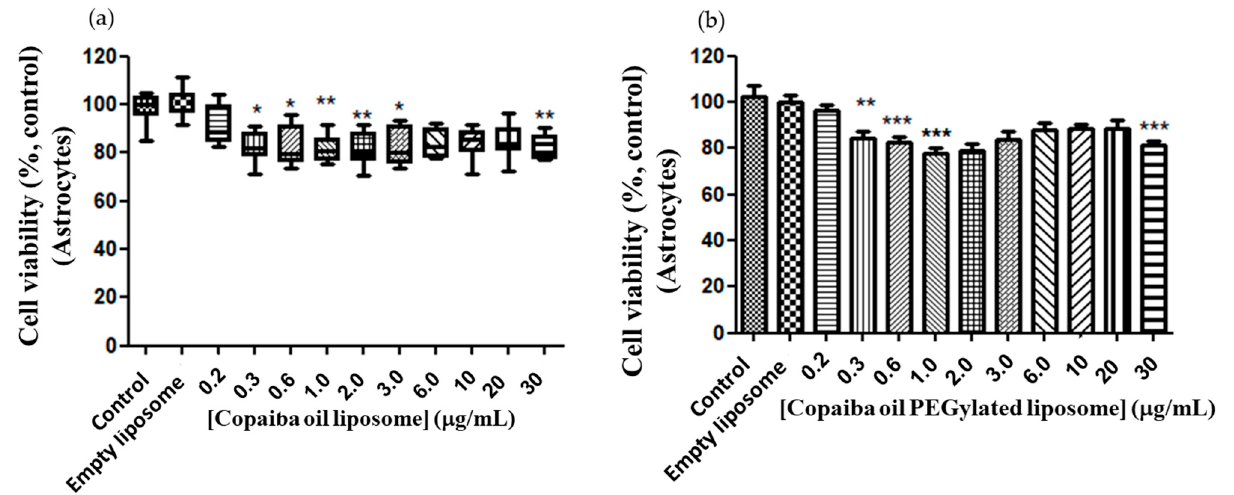
Figure 8. Dose–response curve of astrocytes to conventional and CP-loaded PEGylated liposomes. Treatment at the dose of 0.2 to 30 µ g/mL of copaiba oil in conventional ( a ) and PEGylated ( b ) liposomes for 72 h. ( a )—Data are represented by a non-normal distribution in terms of the median and variation, analyzed by Kruskal–Wallis followed by Dunn’s comparison test. ( b )—Data are represented by a normal distribution in terms of the mean, analyzed by Turkey and all pars columns compared. Statistical significance: (*) p < 0.01, (**) p < 0.001 and (***) p < 0.0001 compared to the control with 0.05% empty